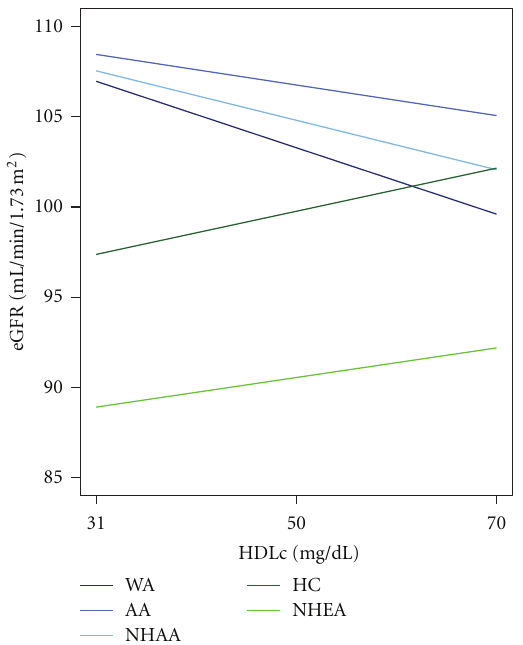
Figure 1: Association between HDLc and eGFR in Diverse Populations. The association of HDLc and eGFR in West Africans (WA), African Americans (from Howard University Family Study, AA), African Americans (from National Health and Nutrition Examination Survey, NHAA), Han Chinese (HC), European Amer- icans (NHEA). Linear models adjusted for age, age 2 , sex, BMI, triglycerides, LDLc, alcohol use, and smoking (and random e ff ect of family for WA and